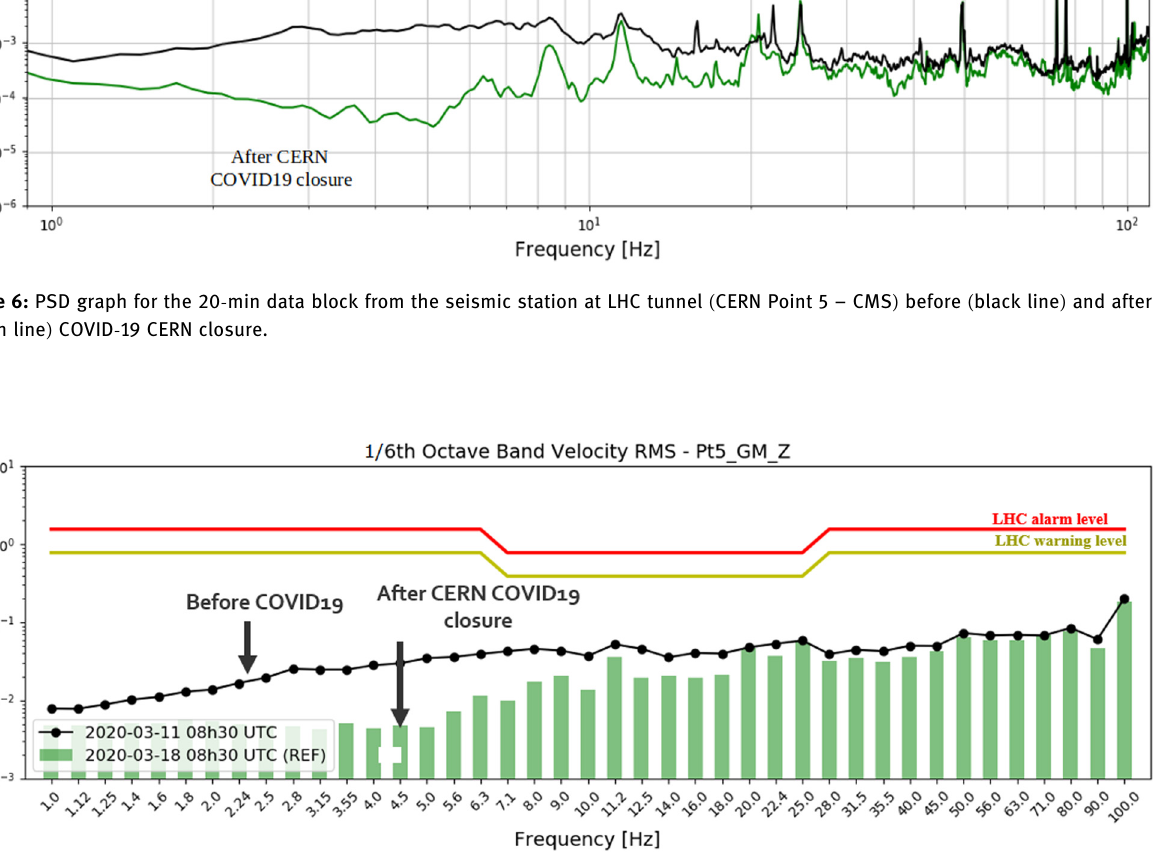
Figure 7: The 1/6th Octave Band Velocity RMS for 20 - min data block, comparison of data before and after the lockdown at CERN point 5 ( CMS ) seismic